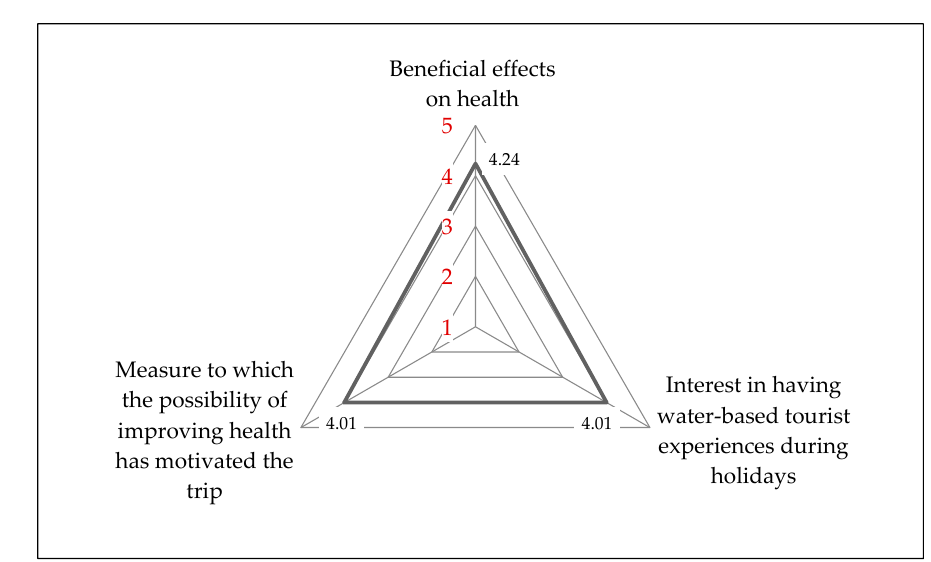
Figure 4. Perceptions about the water-based tourism experiences